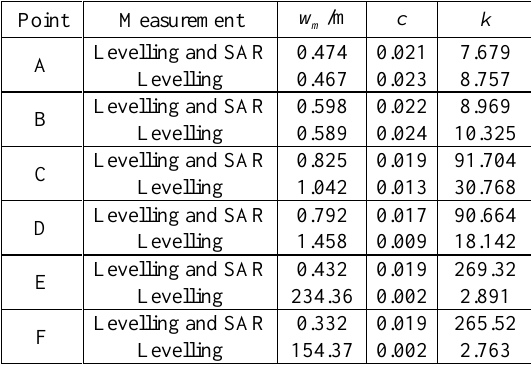
Table 3. The unknown parameters values in six